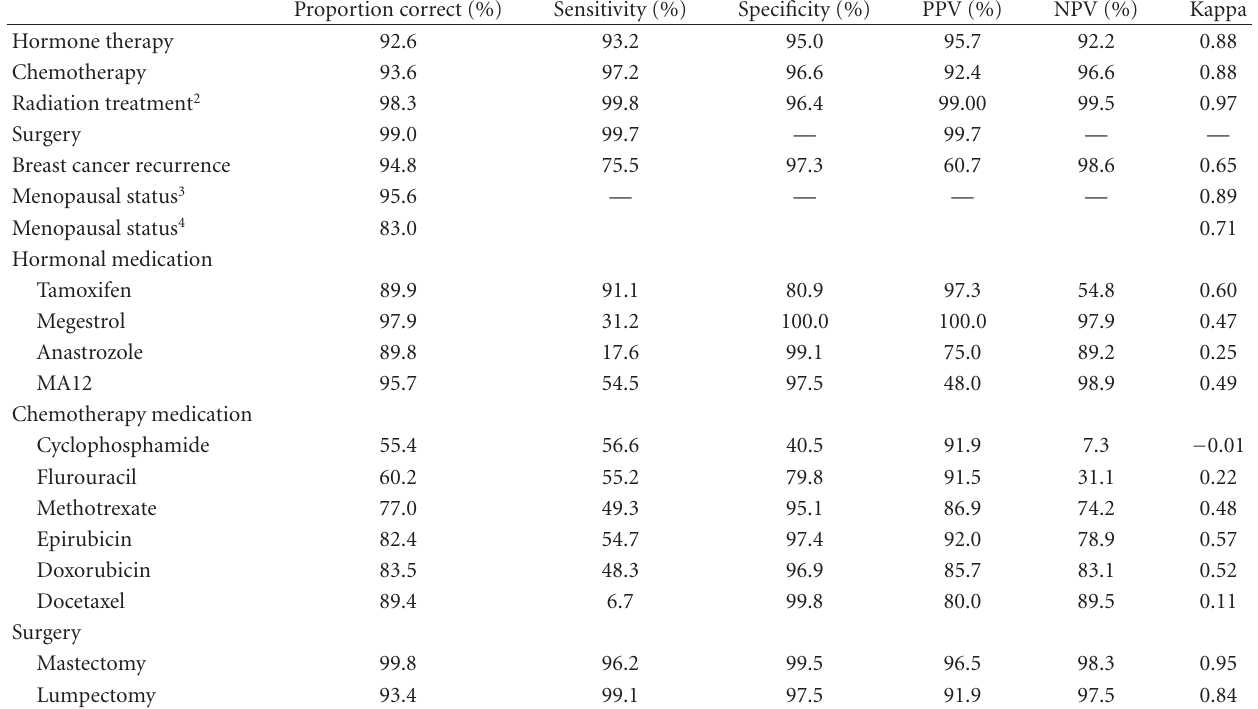
Table 3: Agreement analysis 1 comparing information from self-administered questionnaires with medical record information in 939 women with breast